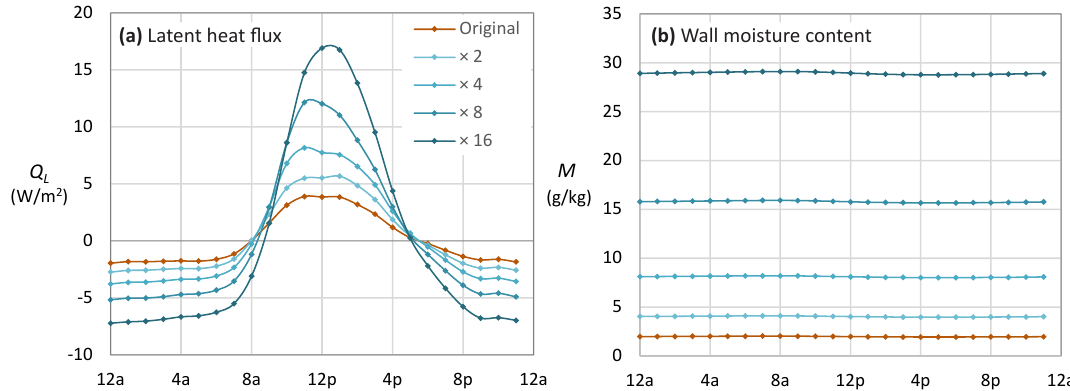
Figure 12. Effect of varying the slope of the moisture retention curve W ( φ ) (Figure 11a) on ( a ) latent heat flux Q L and ( b ) moisture content M of unfired earth brick walls, illustrating the impact of ∂ W / ∂φ on both parameters and its evident importance to intrinsic evaporative cooling. Data show average hourly July values in the marine west coast climate of Clermont-Ferrand, France (Köppen Cfb , Table 3; Figure 9) for south-facing vertical walls; the Original is Cagnon’s Unfired Earth Brick 1 [50]. Ambient humidity was the only source of moisture.